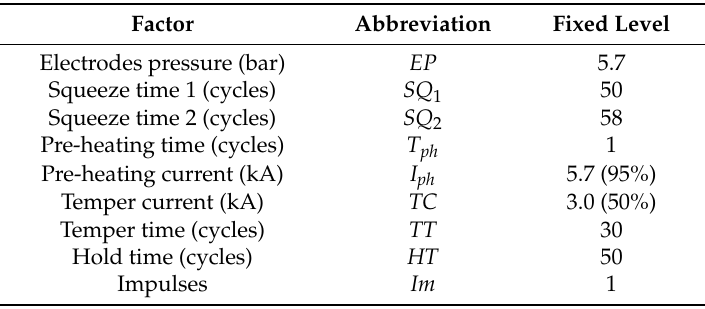
Table 9. Fixed factors.